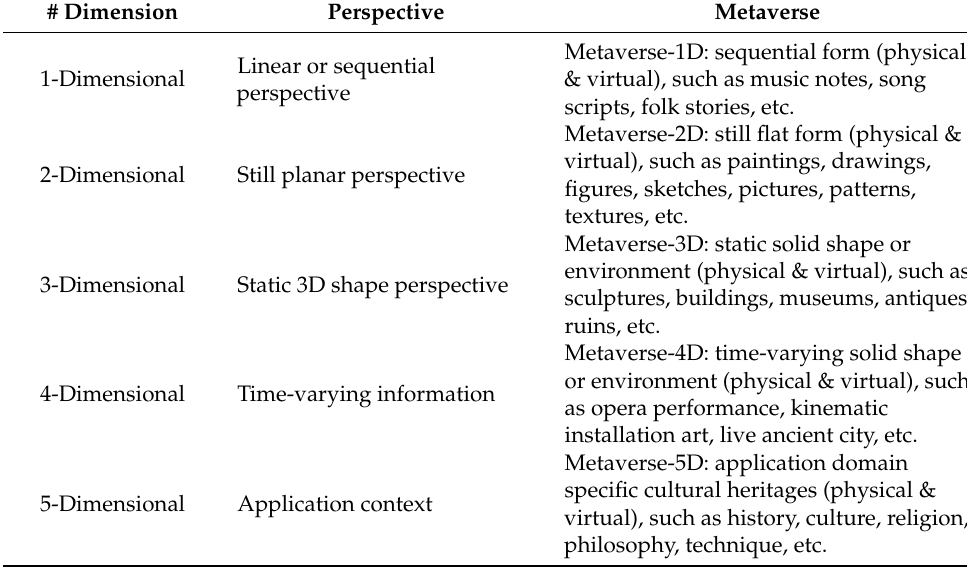
Figure 4. 5 ‐ dimensions of cultural heritage metaverse. Table 2. The 5 ‐ dimensions of cultural heritage metaverse. Table 2. The 5-dimensions of cultural heritage